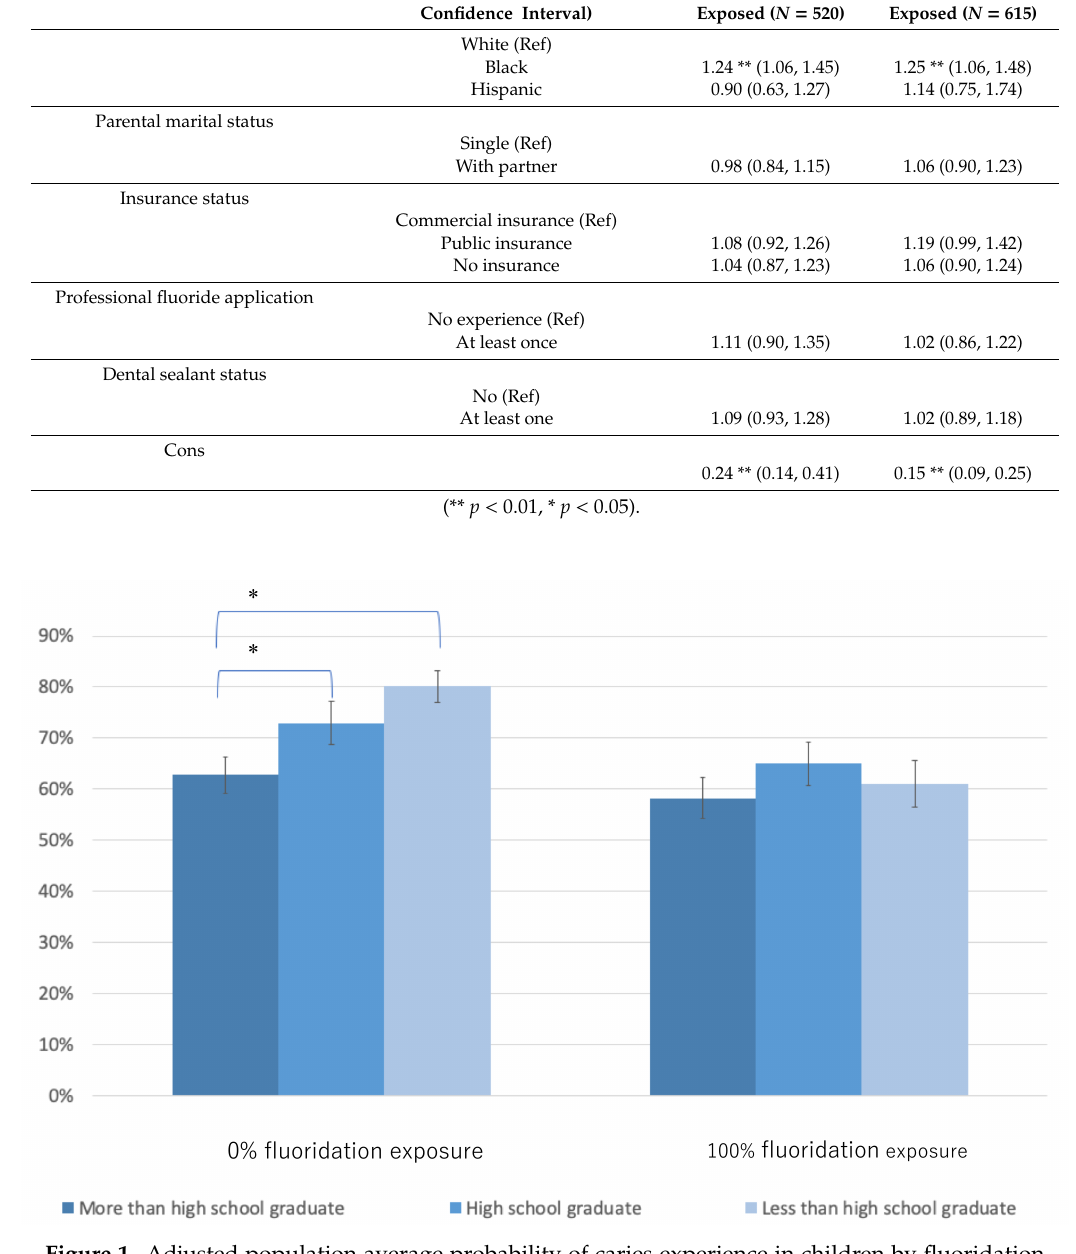
Figure 1. Adjusted population average probability of caries experience in children by fluoridation exposure level and parental educational